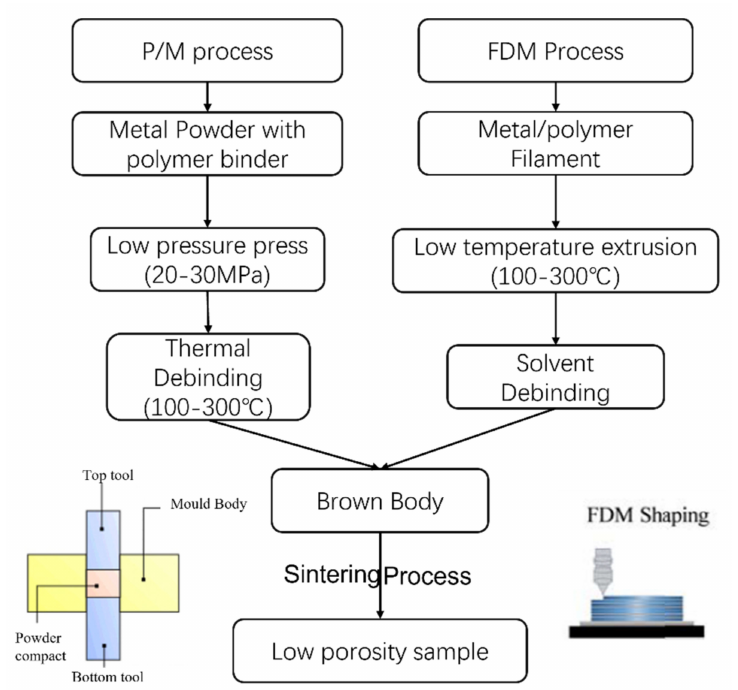
Figure 1. P/M-basedspecimenpreparationmethodforthestudyofmetallicFDMAMprocessingstrategies.